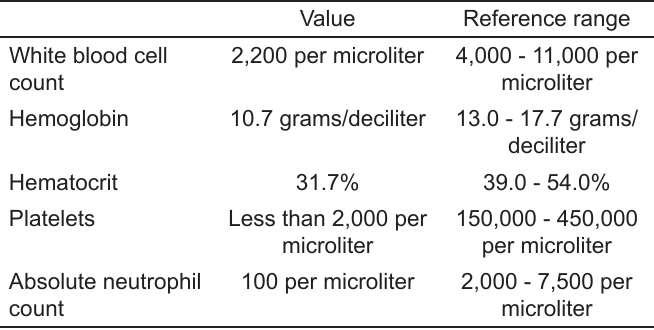
Table. Emergency department laboratory